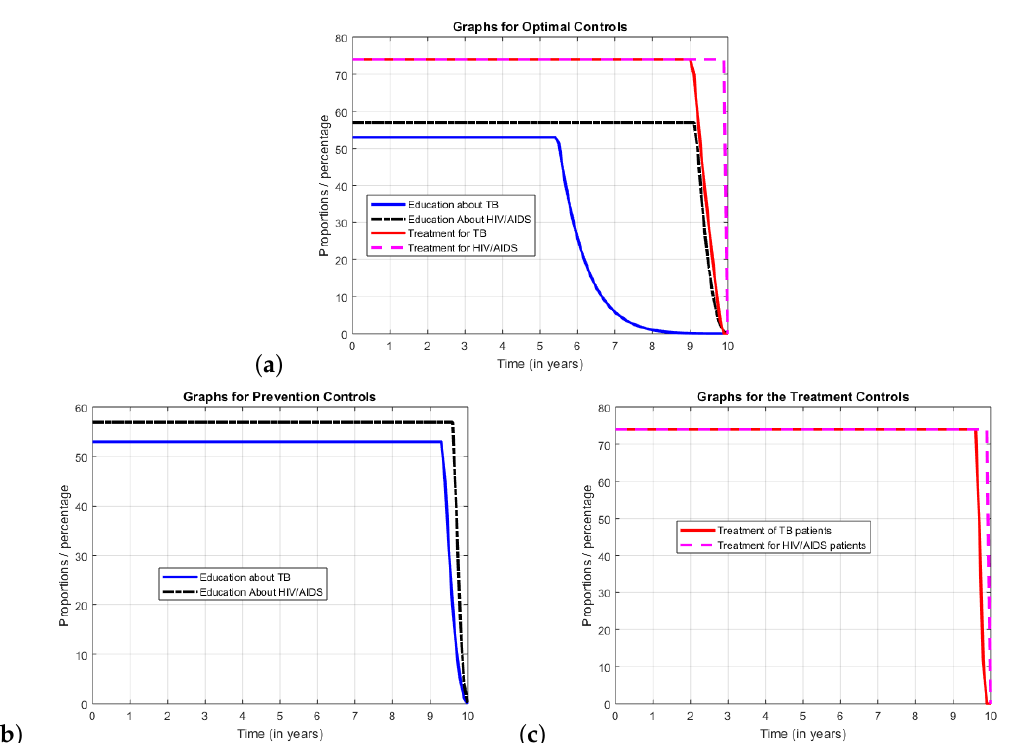
Figure 4. Graphs for the Optimal controls ( a ) when all the controls are applied and ( b ) when only preventive controls are applied, and ( c ) when only treatment controls are applied. All the parameter values are as described in the caption of Figure 2.